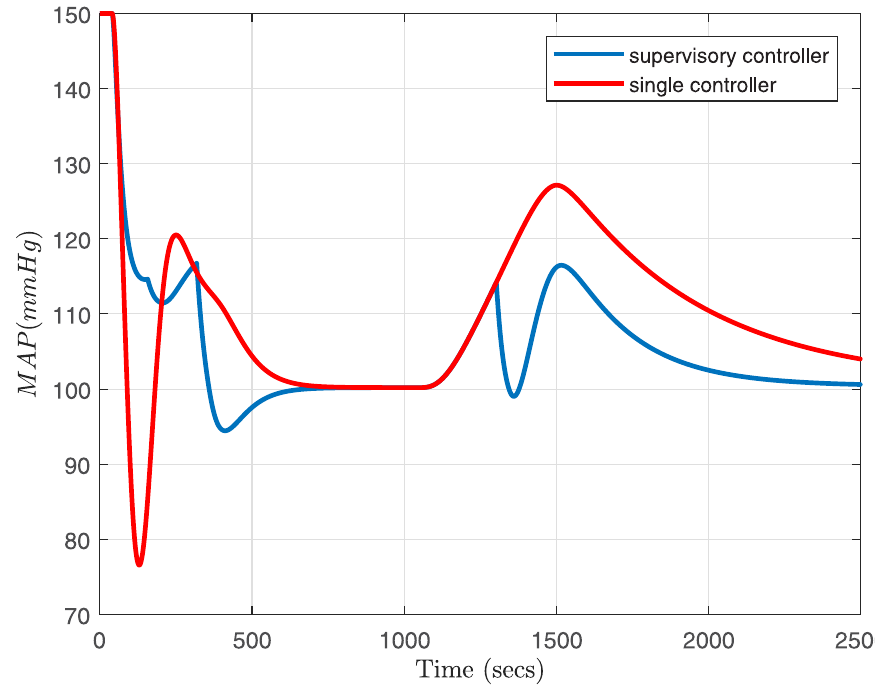
Fig 9. Curve of mean arterial pressure, Δ M ( t ).